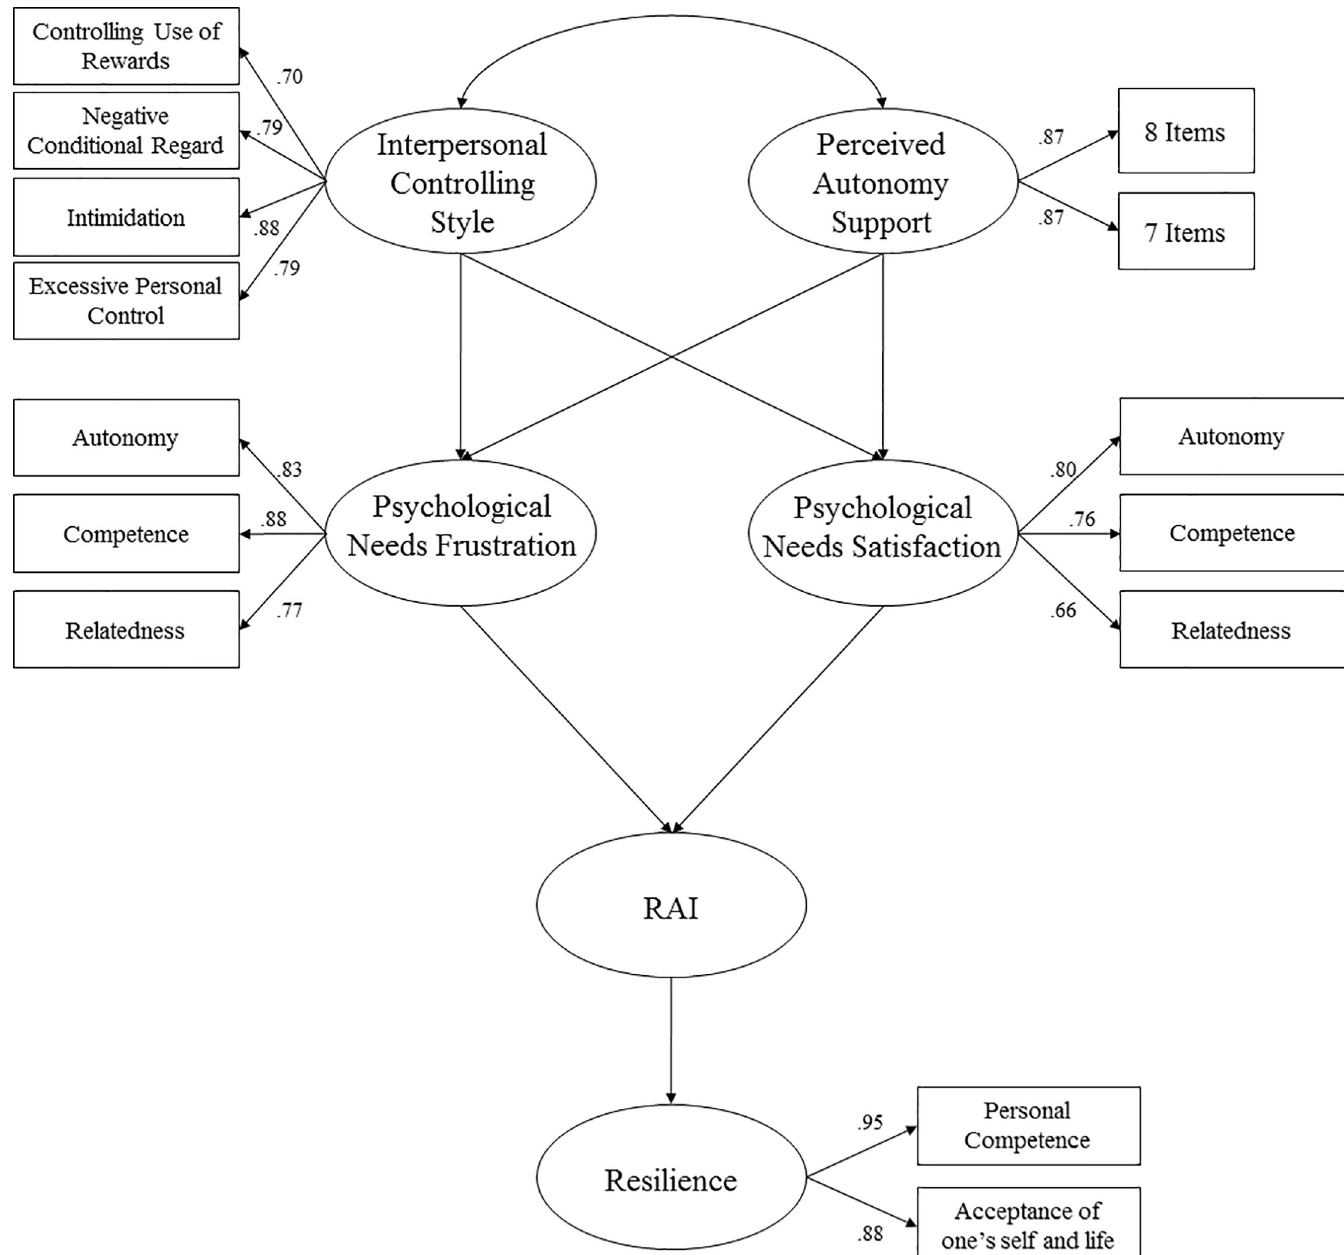
Fig 1. Hypothesized model in the sports context from the perspective of self-determination